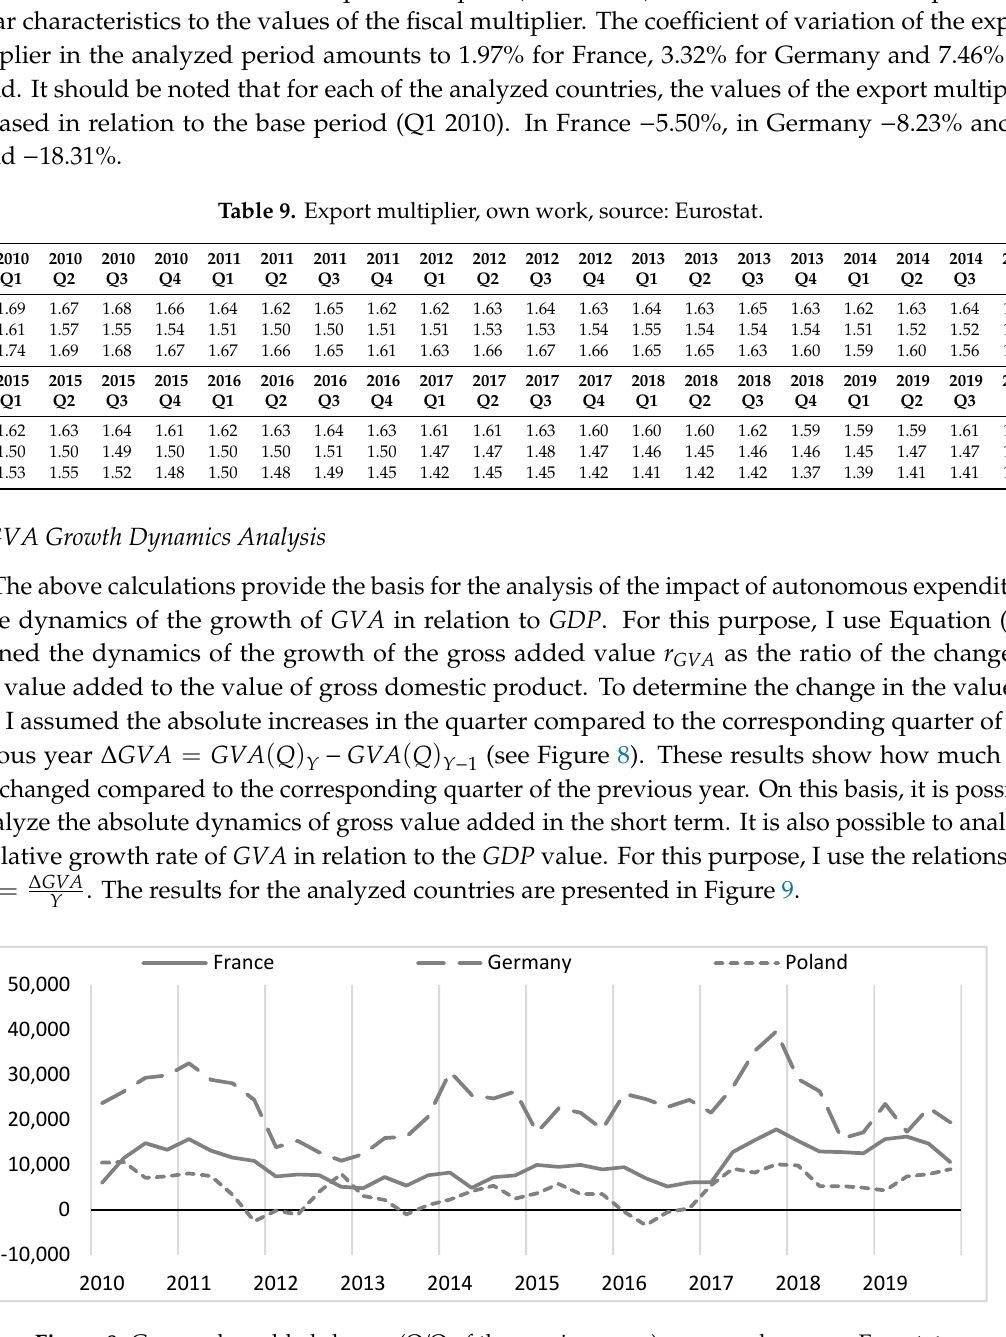
Figure 8. Gross value added change (Q/Q of the previous year), own work, source: Eurostat.